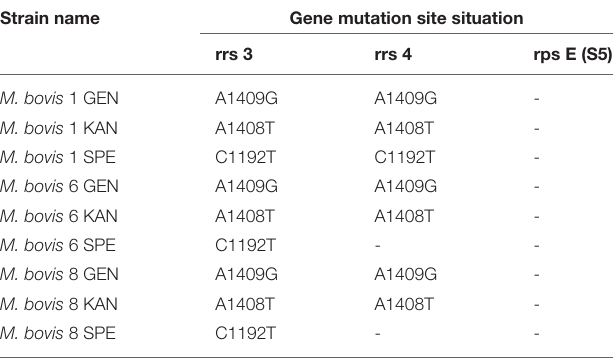
TABLE 6 | The mutations of target genes in strains induced in vitro to